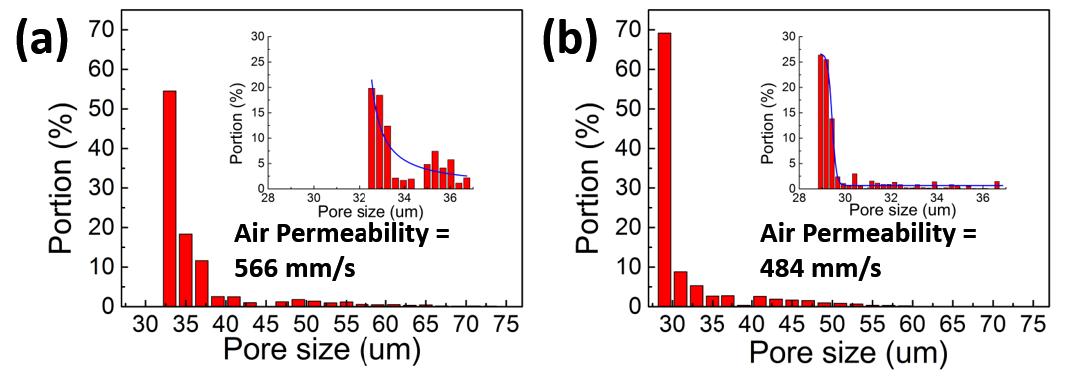
Figure 6. Pore size distribution and air permeability of conventional melt-blown fabric ( a ) and electrostatic-assisted melt-blown fabric ( b ).